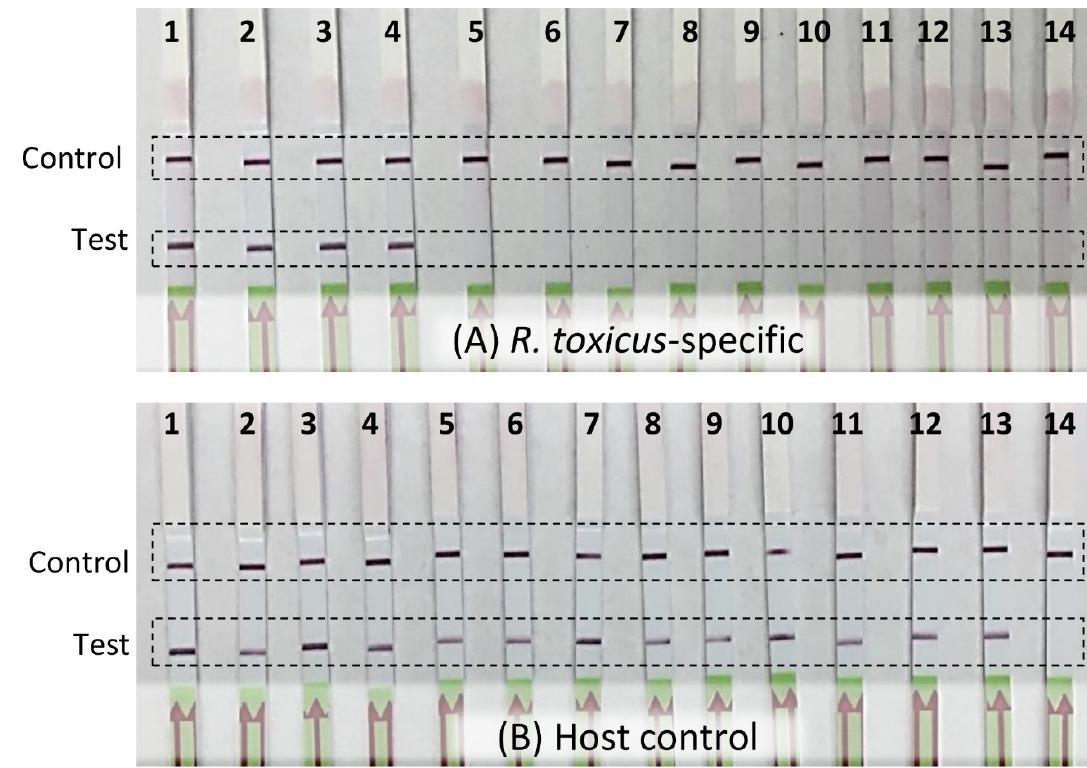
Figure 3. Detection of Rathayibacter toxicus from annual ryegrass samples using a recombinase polymerase amplification (RPA) assay. Annual ryegrass samples were collected in 2014 at multiple locations in South Australia and Western Australia; DNA was isolated and RPA assays were performed using ( A ) R. toxicus -specific primers/probe and ( B ) host plant-specific primers/probe. Lane A1: positive control ( R. toxicus strain SA03-04); lane B1: positive control (annual ryegrass DNA); lanes A2–A12 and B2–B12: field sample SA03; SA08; SA19; SA70; WA06; WA08; WA41; WA61; WA64; WA68; WA69; lanes A13 and B13: negative control (host DNA); lanes A14 and B14: water (non-template control).